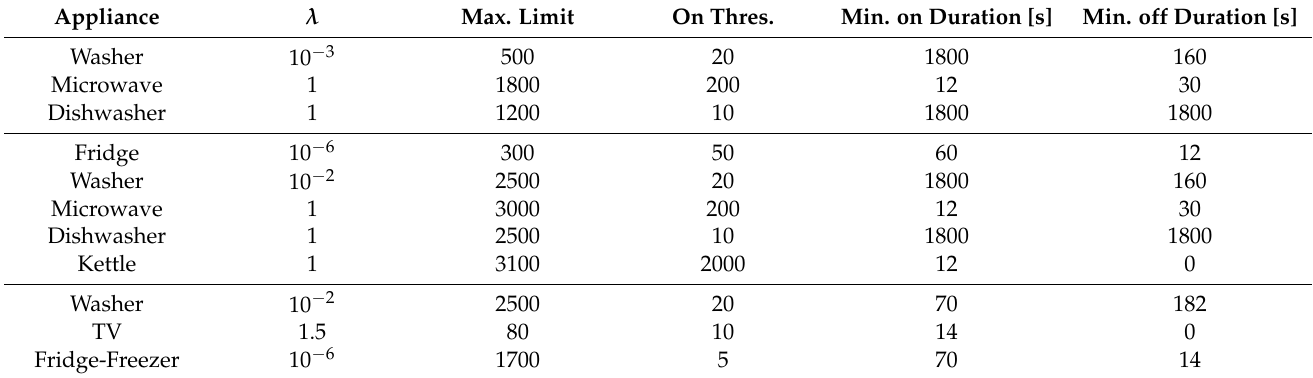
Table 1. Pre-processing values for the REDD (upper), UK-DALE (middle) and Refit (lower) datasets. Appliance λ Max. Limit On Thres. Min. on Duration [s] Min. off Duration